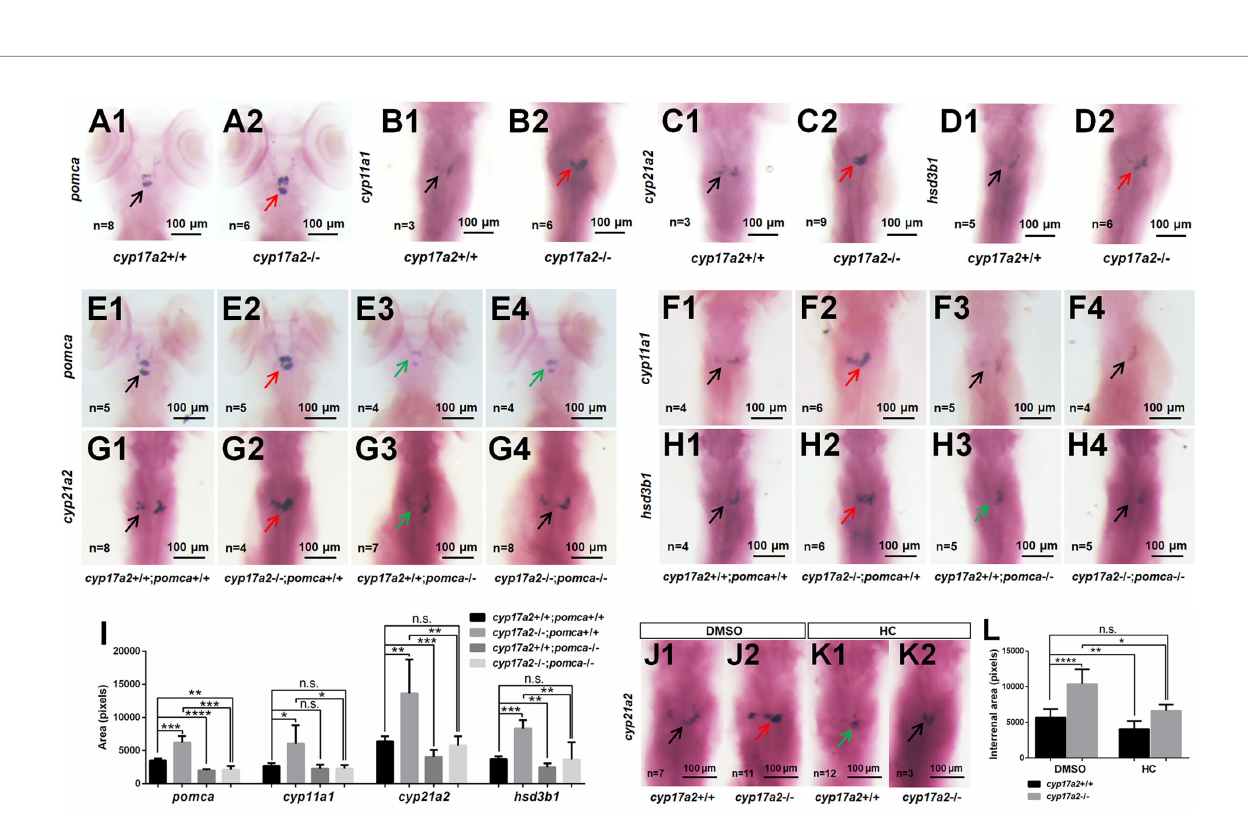
FIGURE 2 | cyp17a2 -de fi ciency caused pituitary pomca upregulation and interrenal gland enlargement in zebra fi sh larvae. WISH analyses with probes of pomca (A1, A2) , cyp11a1 (B1, B2) , cyp21a2 (C1, C2) and hsd3b1 (D1, D2) in cyp17a2 +/+ and cyp17a2 -/- fi sh at 5 dpf. WISH analyses with probes of pomca (E1 – E4) , cyp11a1 (F1 – F4) , cyp21a2 (G1 – G4) , and hsd3b1 (H1 – H4) in fi sh at 5 dpf. (E1, F1, G1, H1) cyp17a2 +/+; pomca +/+ fi sh. (E2, F2, G2, H2) cyp17a2 -/-; pomca +/+ fi sh. (E3, F3, G3, H3) cyp17a2 +/+; pomca -/- fi sh. (E4, F4, G4, H4) cyp17a2 -/-; pomca -/- fi sh. Black, red, and green arrows indicate normal, enlarged, and decreased interrenal gland, respectively. (I) Bar chart represents the quanti fi cation and statistical analyses of WISH signals in pituitary and interrenal gland of fi sh at 5 dpf. (J1, J2, K1, K2) WISH analysis using the probe of cyp21a2 in cyp17a2 +/+ and cyp17a2 -/- fi sh administrated with DMSO or HC from 1 dpf to 5 dpf. (J1, J2) DMSO. (K1, K2) HC. (L) Bar chart represents the quanti fi cation and statistical analyses of WISH signals in interrenal gland of fi sh administrated with DMSO or HC. HC, hydrocortisone. DMSO, dimethyl sulfoxide. n.s., no signi fi cant difference. * P < 0.05. ** P < 0.01. *** P < 0.001. **** P <